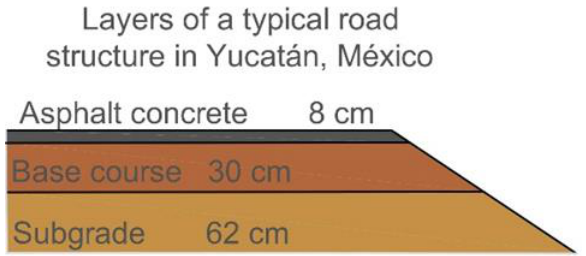
Figure 2. Schemes of layers and thickness of a typical road structure in Yucatán [23].